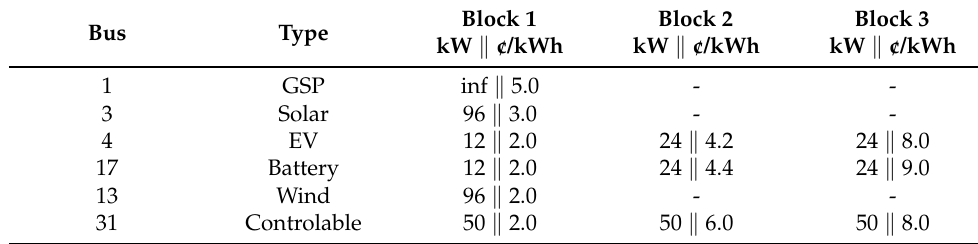
Figure 5. IEEE 33 bus feeder with optimal generation, flexible load, and storage locations. Table 2. Generator Offers.